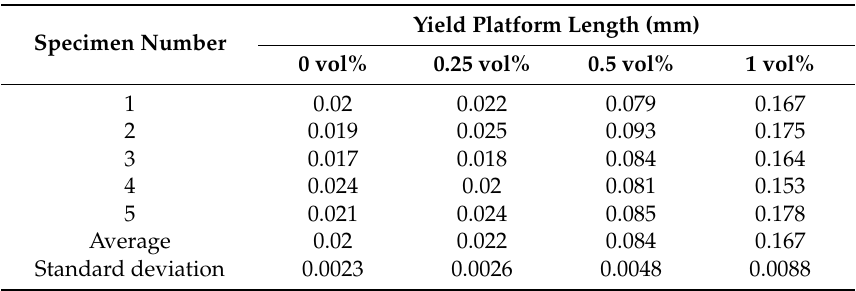
Figure 7. Schematic diagram showing definition of the yield platform length. Table 5. Yield platform length of unpinned Cf/Al composites and z-pinned Cf/Al composites using stainless steel pins with diameters of 0.3 mm measured by short-beam shear test.